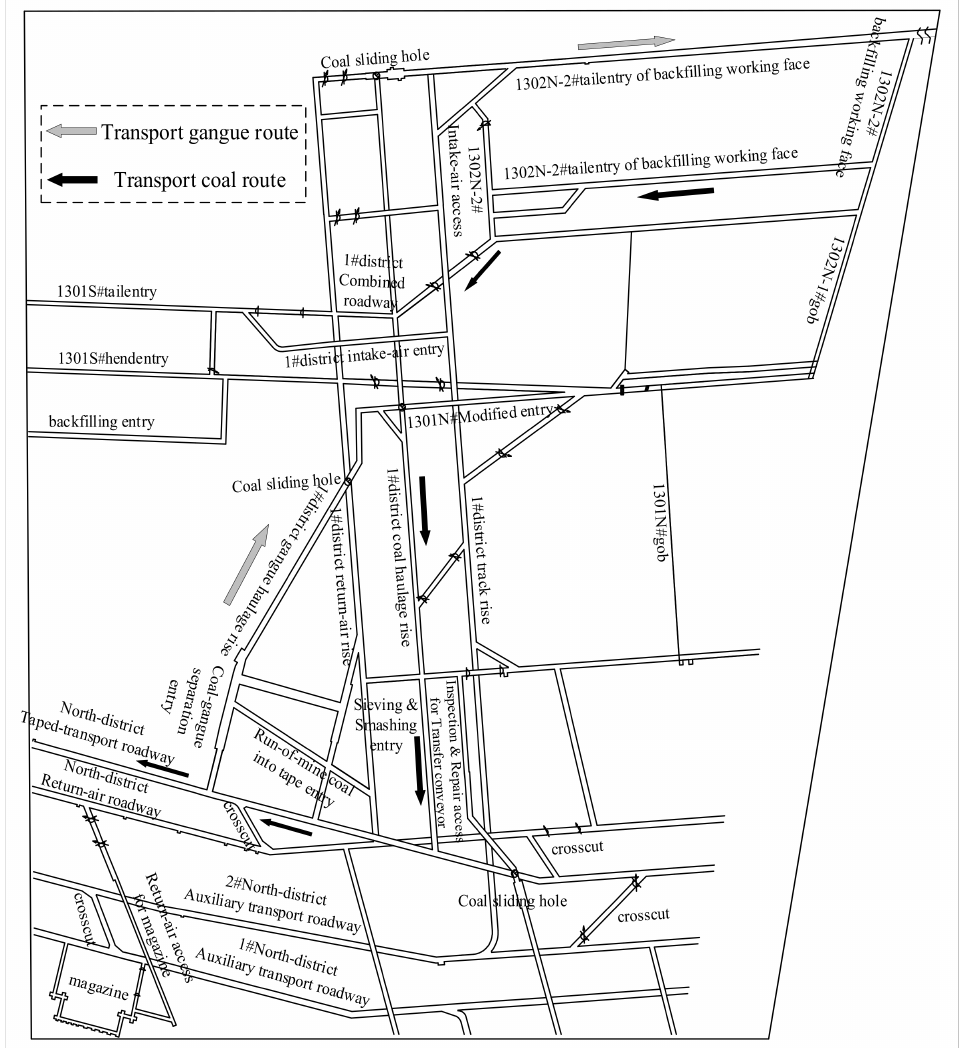
Figure 3. Schematic diagram of coal gangue logistics and transportation system in the Xinjulong coal